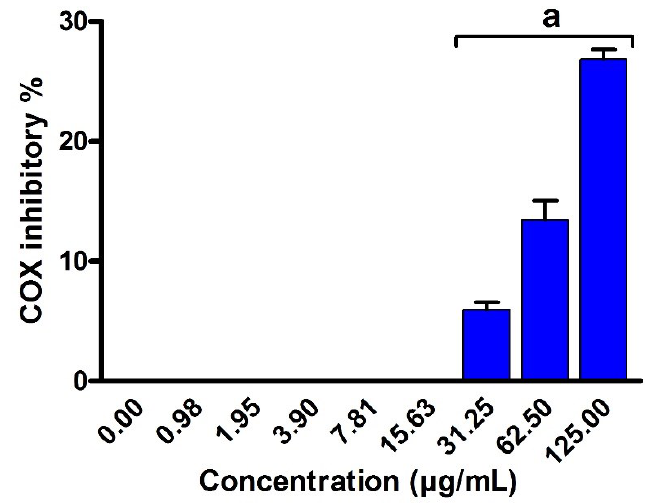
Figure 11. Assessment of the inhibitory activity of EPSR4 against COX-2 enzymatic activity. Data are presented as mean ± SD. a p < 0.05 versus concentration of 0 μg